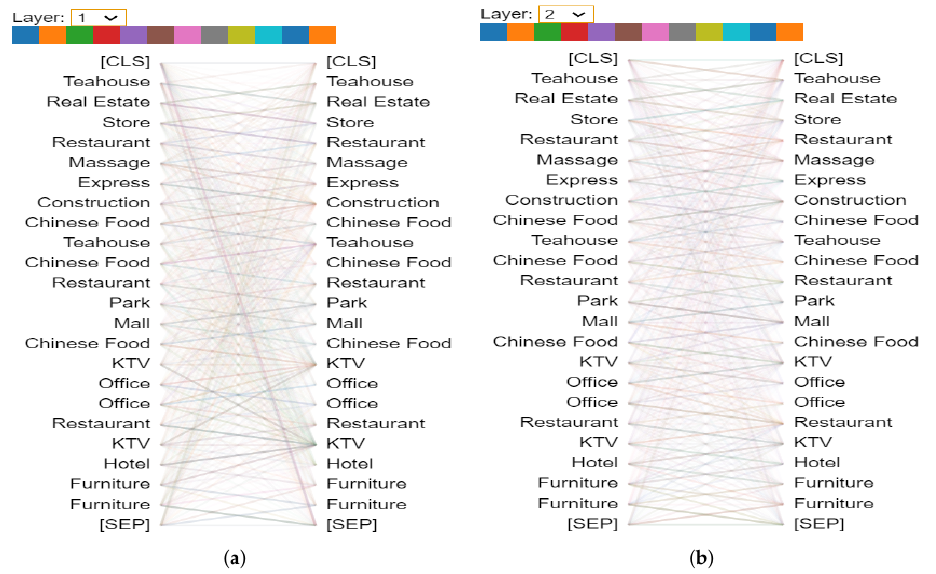
Figure 15. Attention Layer 1 and Layer 2 in GeoBERT-ShortestPath. We can see pairs of cross lines between adjacent tokens, which means that GeoBERT has learned the position information between adjacent tokens. ( a ) Attention Layer 1; ( b ) Attention Layer